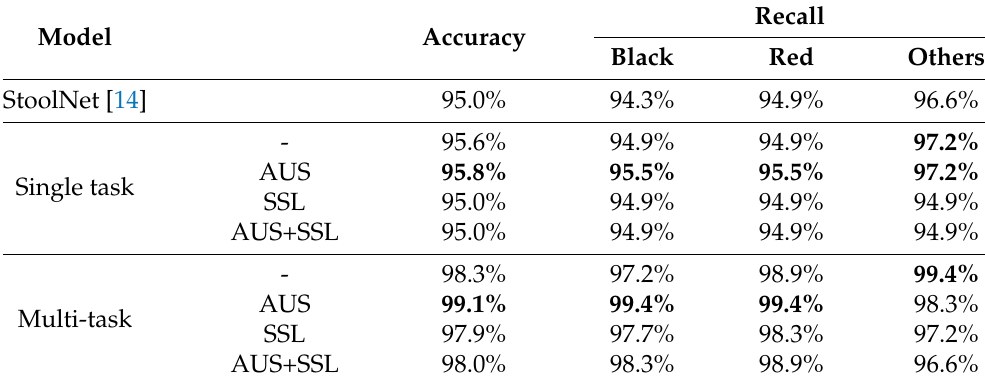
Table 7. Results for three color categories in real scenes.